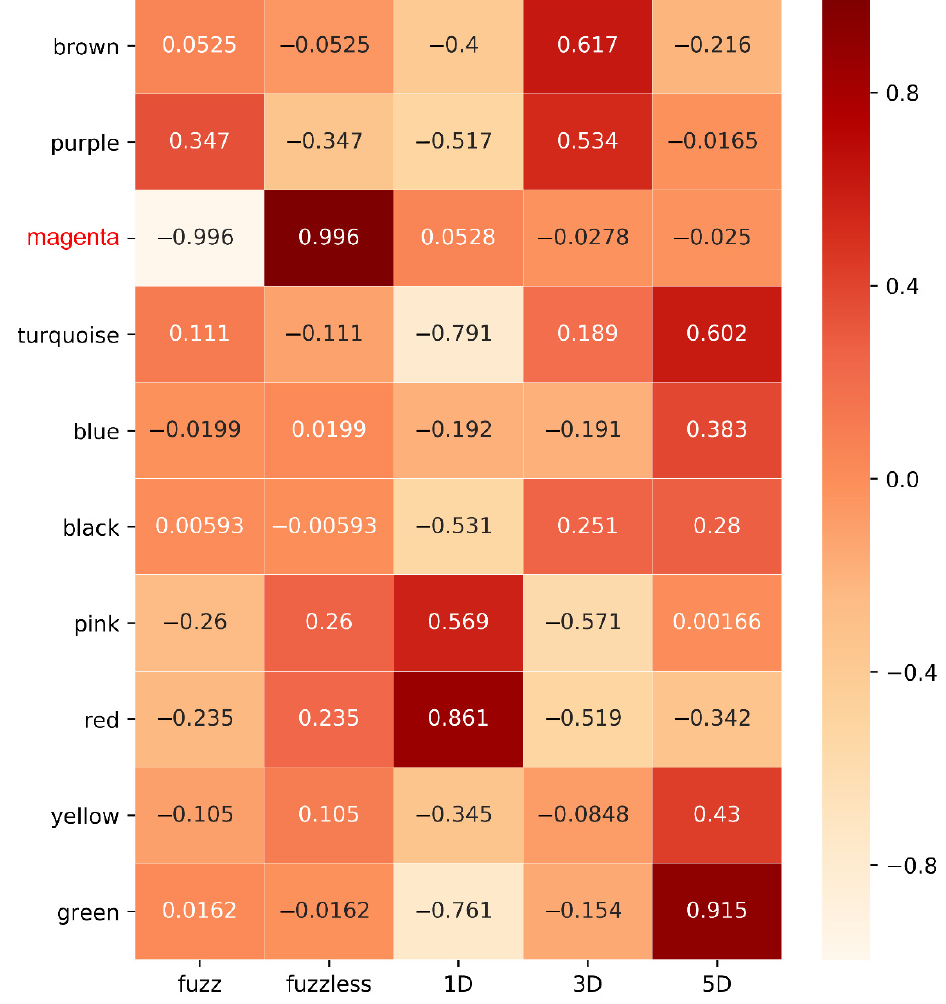
Figure 5. The WGCNA showed the MEmagenta module is significantly associated with fuzz formation. Each row means a module, and the correlation coefficient are shown in each square and the p -value was list in Table S4. The names in red in left represent the module highly associated with fuzz development.